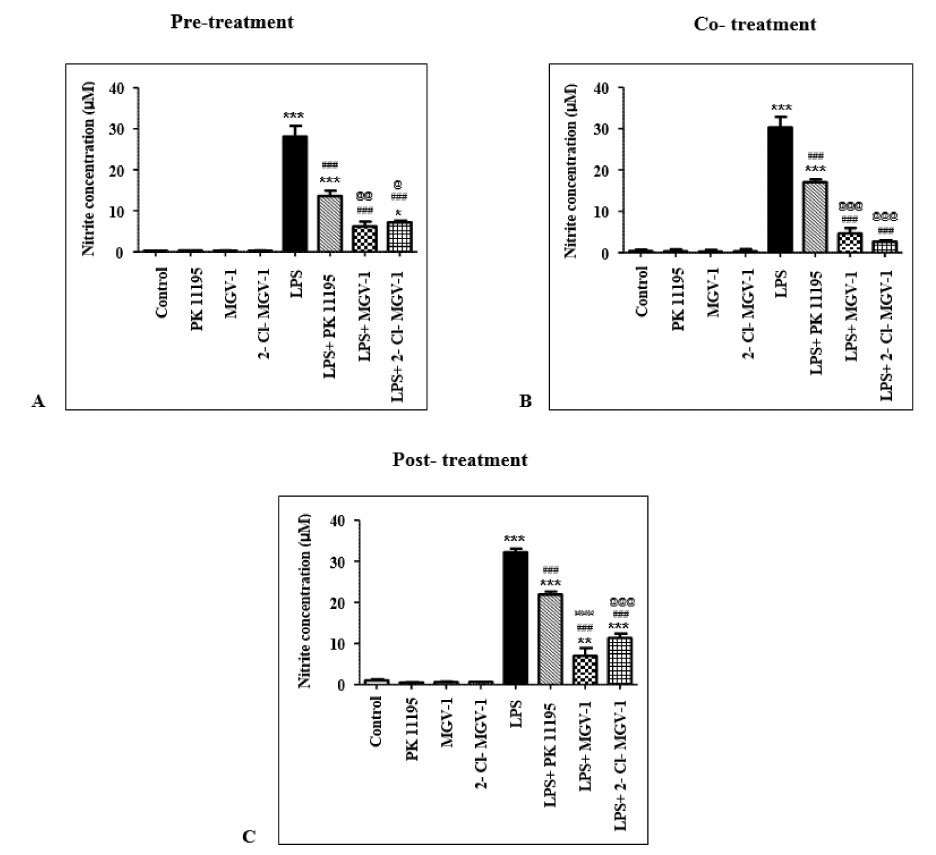
Figure 3. TSPO ligands reduced nitrite levels in LPS-treated BV-2 cells. BV-2 cells were treated with 100 ng/mL LPS for 24 h, with or without TSPO ligands (25 µ M) in three different scenarios. A , B,C : Nitrite concentrations ( µ M) in pretreatment, cotreatment, and post-treatment, respectively, with TSPO ligands. Nitrite levels are presented as means ± SEM; n = 3 (pretreatment), n = 3 (cotreatment), n = 3 (post-treatment). * p < 0.05, ** p < 0.01, *** p < 0.001 compared to Control; ### p < 0.001 compared to LPS; @ p < 0.05, @@ p < 0.01, @@@ p < 0.001 compared to LPS + PK